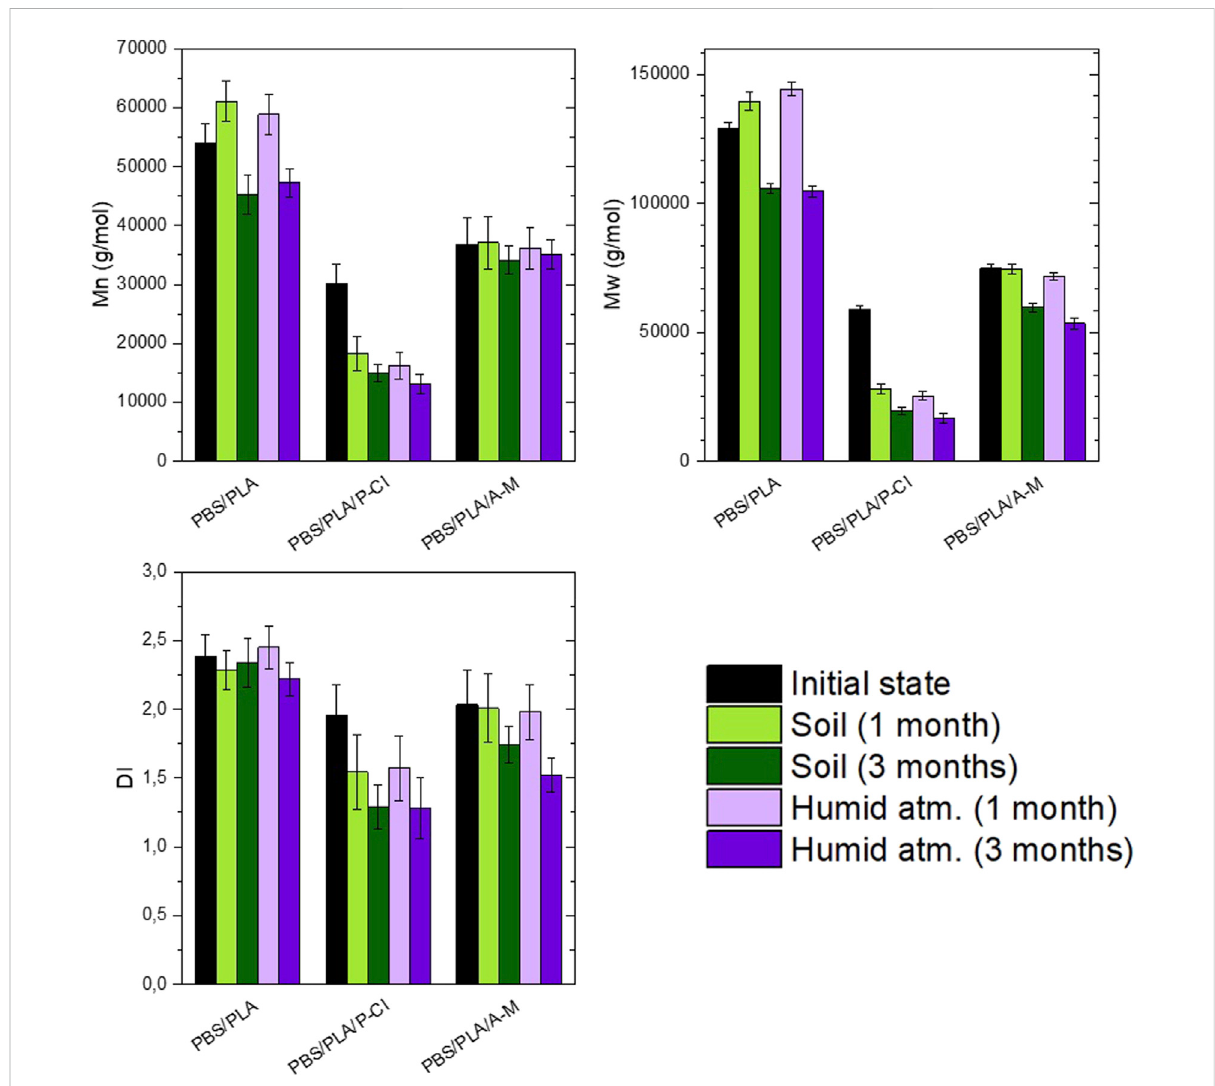
FIGURE 10 Mn, Mw and dispersity index measured with CHCl 3 -SEC, after degradation under soil burial conditions, and in humid atmosphere at room